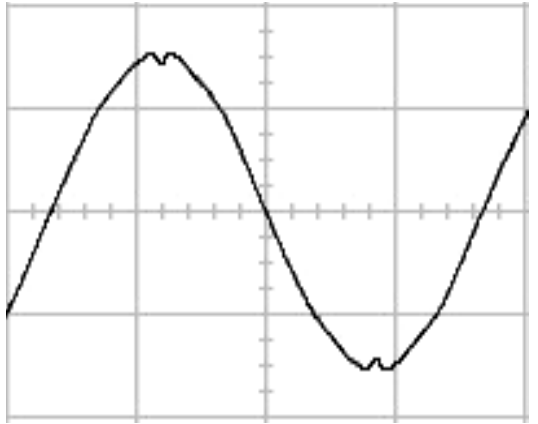
Figure 15. Experimental AC output voltage for the proposed method under a sudden increment of load (vertical: 100 V/div and 5 ms/div).